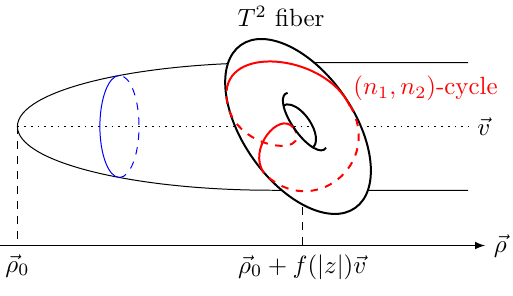
Figure 3 . Open cigar in the 5 2 -brane geometry whose boundary is given by the ( n 1 ; n 2 )-cycle. 2